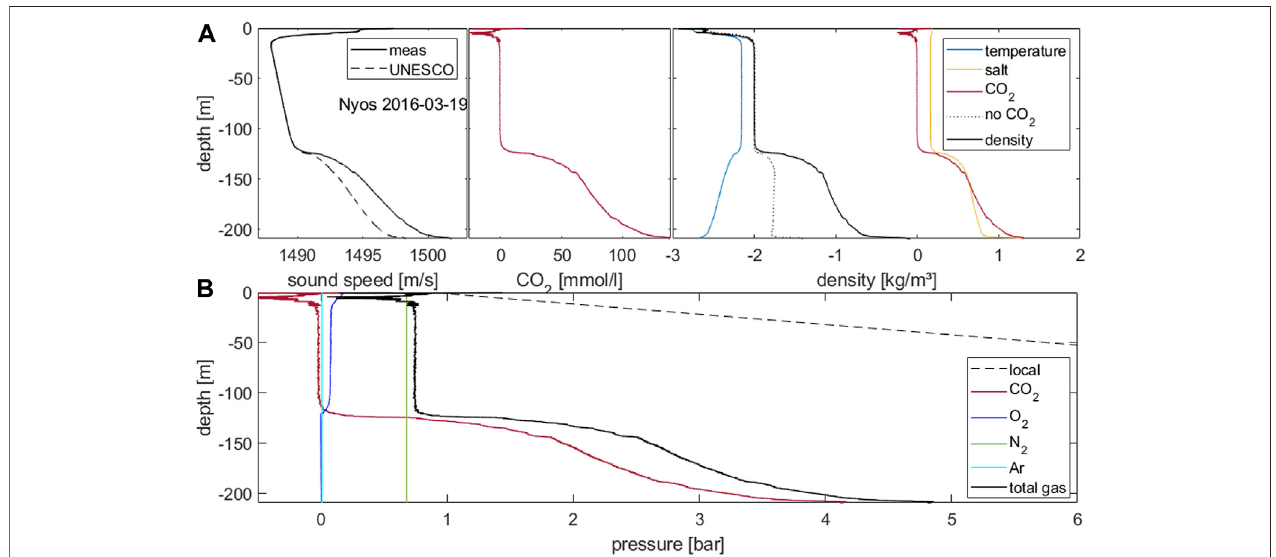
FIGURE4|(A) :Soundspeedasmeasuredandcalculatedfromtemperature,electricalconductivityandpressurefollowingUNESCOformula.Middlepanel:pro fi le of calculated carbon dioxide concentrations as derived from the sound speed excess. Right panel: (potential) density ( − 1,000 kg/m 3 ) as calculated from measured temperature, EC and carbon dioxide concentration and the single contributions. (B) : pro fi les of gas pressure calculated for the major contributing gases and total gas pressure as the sum in comparison to local pressure.